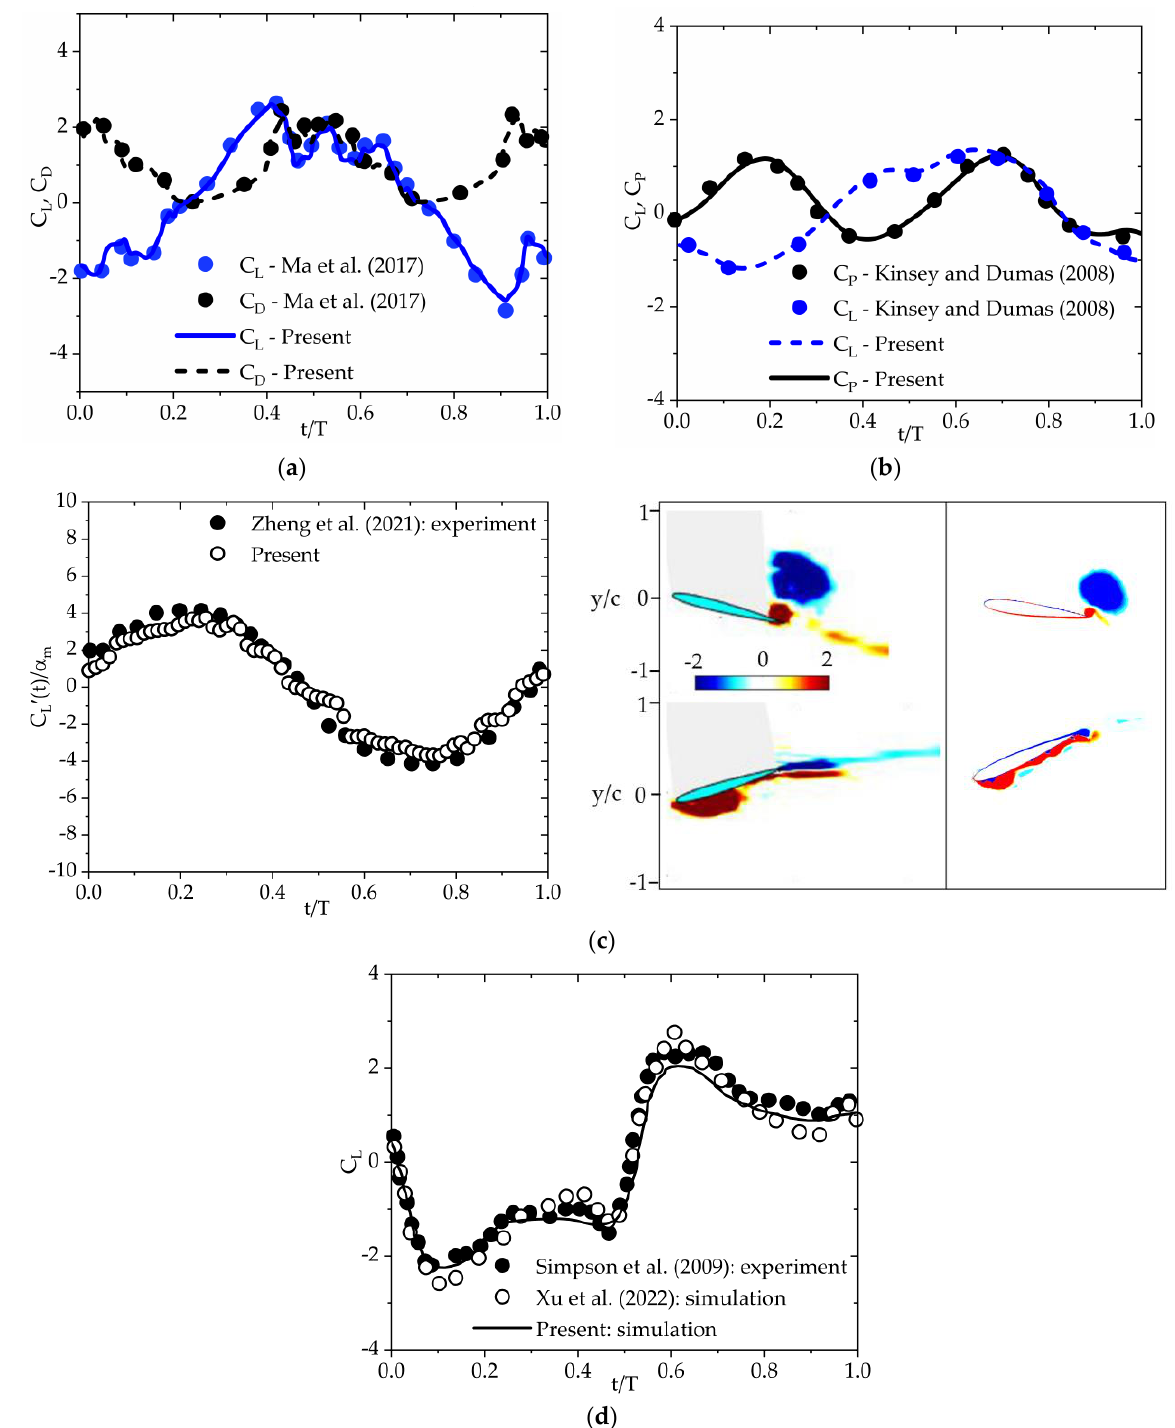
Figure 3. A comparison of force and power coefficients obtained from the present study with the findings of previous studies. ( a ) Present study vs. Ma et al. [14], ( b ) Present study vs. Kinsey and Dumas [7], ( c ) Present study vs. Zheng et al. [56], and ( d ) Present study vs. Simpson et al. [57] and Xu et al. [49].